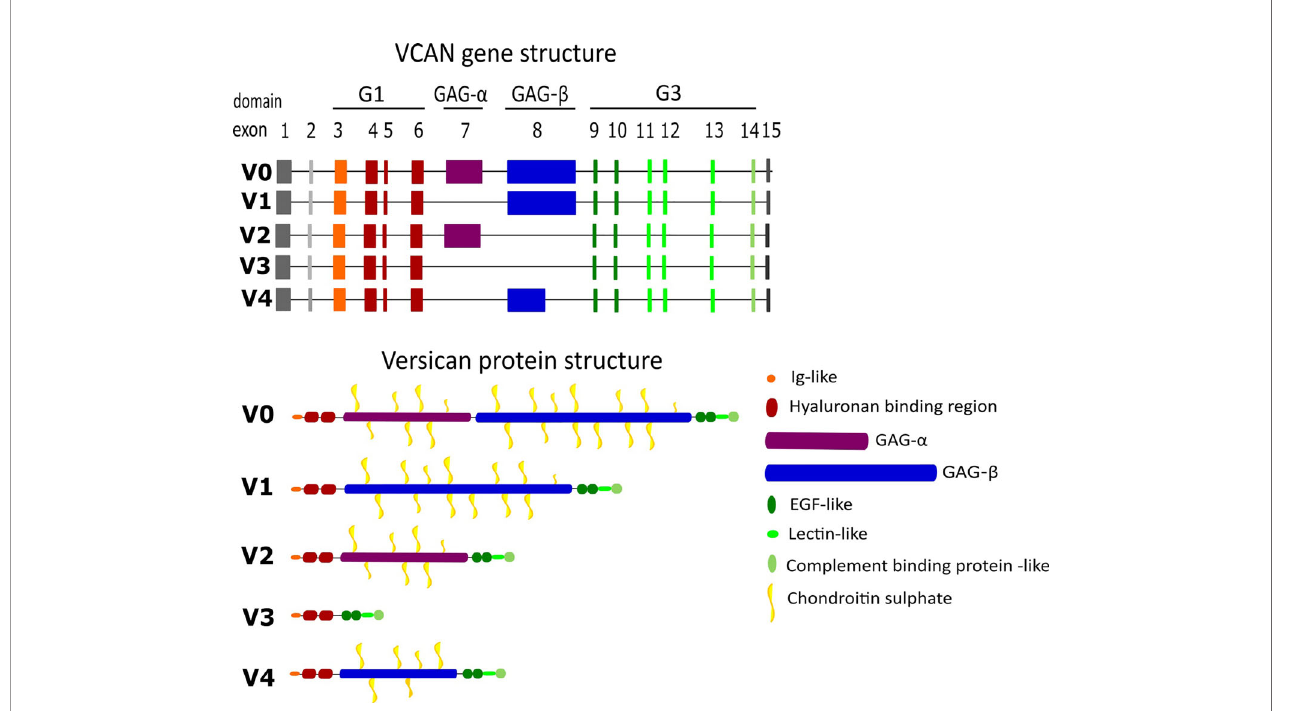
FIGURE 2 | Gene and protein structure of the different versican isoforms. Versican is formed of multiple motifs and domains which contribute to its binding